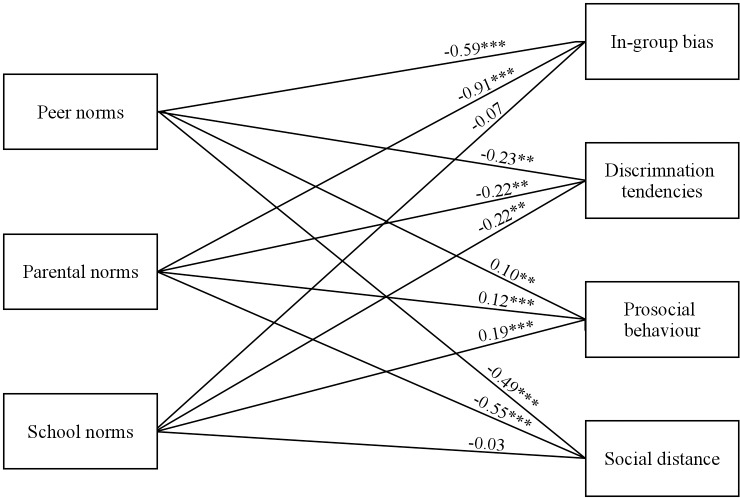
Path model of normative effects on intergroup outcomes for the total sample.Predictor path estimates are unstandardised regression coefficients (b). ** p < 0.01, *** p < 0.001.